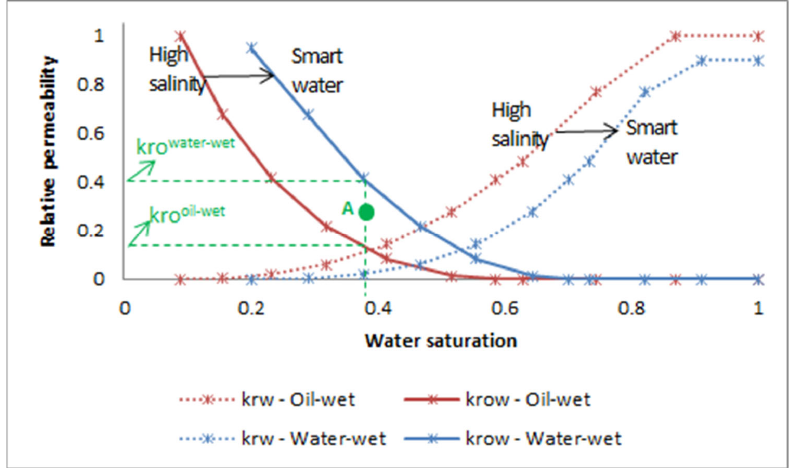
Figure 2. Water–oil relative permeability curves available in Dang et.al